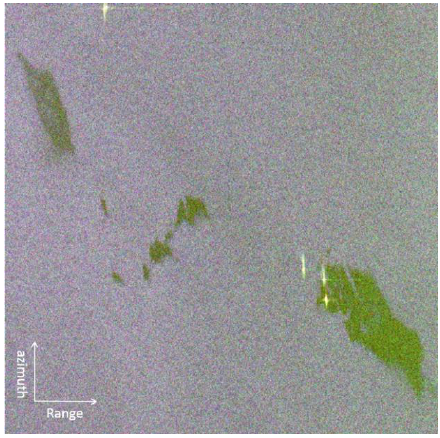
Figure 2. Pauli RGB image of RADARSAT-2 data.